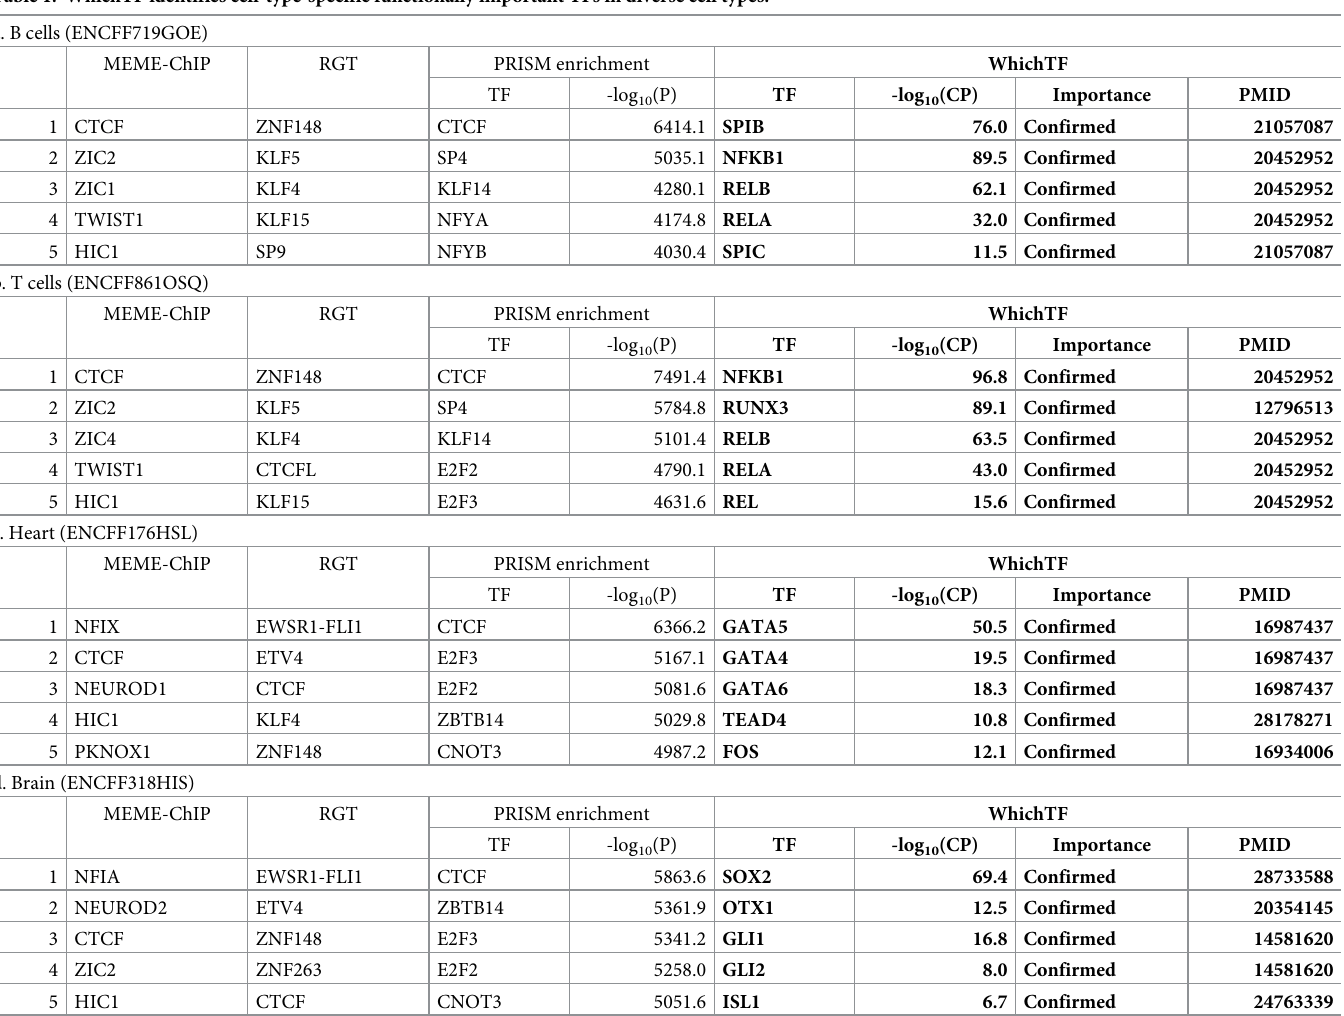
Table 1. WhichTF identifies cell-type-specific functionally important TFs in diverse cell